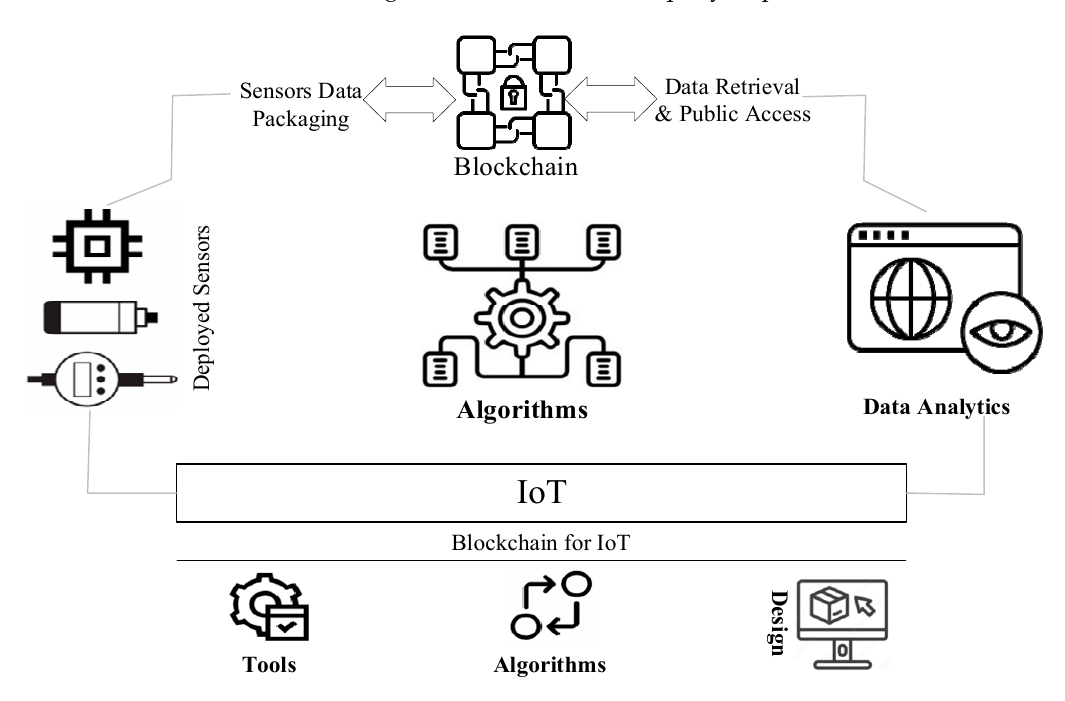
Figure 1. Overview of the recommended Model.